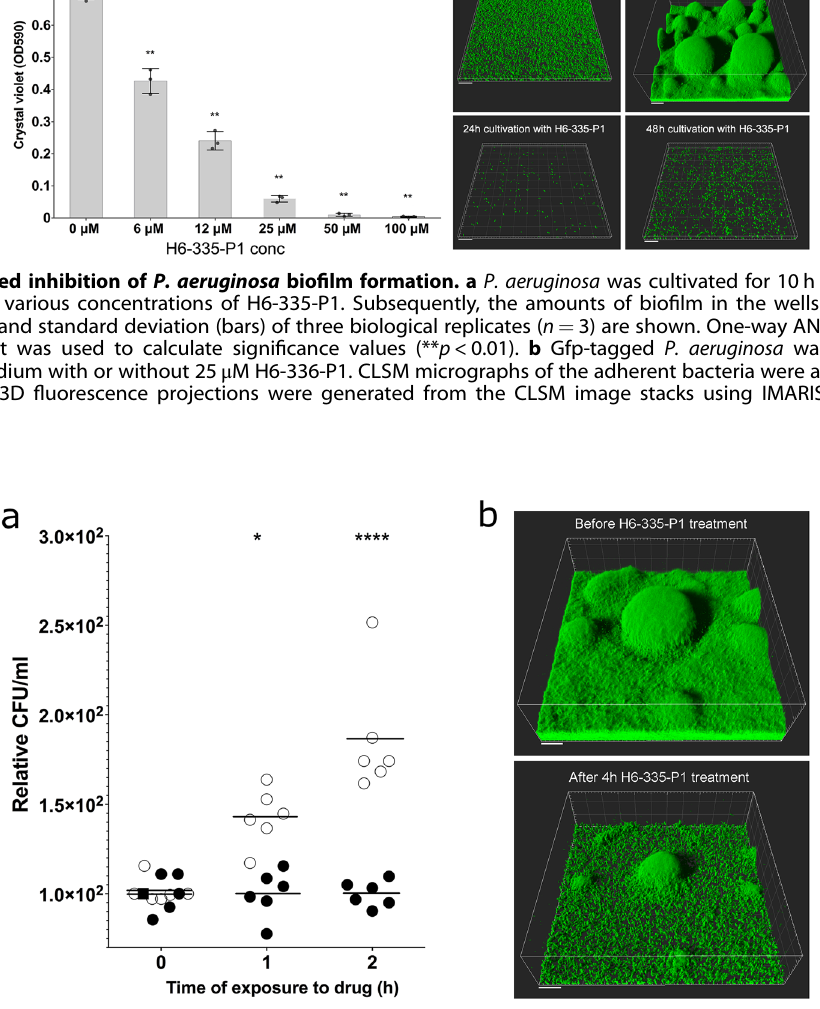
Fig. 5 H6-335-P1-mediated dispersal of P. aeruginosa bio fi lms. a P. aeruginosa bio fi lms were grown in the wells of microtiter trays as 12 biological replicates ( n = 12). After 18 h of cultivation 25 μ M H6-335-P1 ( n = 6, open circles) or 1% DMSO-control ( n = 6, fi lled circles) was added. Subsequently, at the time-points indicated, samples were withdrawn and plated for CFU determinations. Average CFU ’ s per ml for the DMSO controls at each time point were set to 100. Horizontal bars represent mean values. Two-way ANOVA analysis with Sidak ’ s multiple comparisons test was used to calculate signi fi cance values (* p < 0.05, **** p < 0.0001). b A bio fi lm of Gfp-tagged P. aeruginosa was cultivated in a fl ow-cell irrigated with growth medium supplemented with 0.025% DMSO. After 48 h of cultivation, the fl ow-through medium was shifted so that it contained 0.025% DMSO and 25 μ M H6-335-P1. CLSM micrographs were acquired before and 4 h after the introduction of H6-336-P1. Simulated 3D fl uorescence projections were generated from the CLSM image stacks using IMARIS software. The size bars correspond to 20 μ